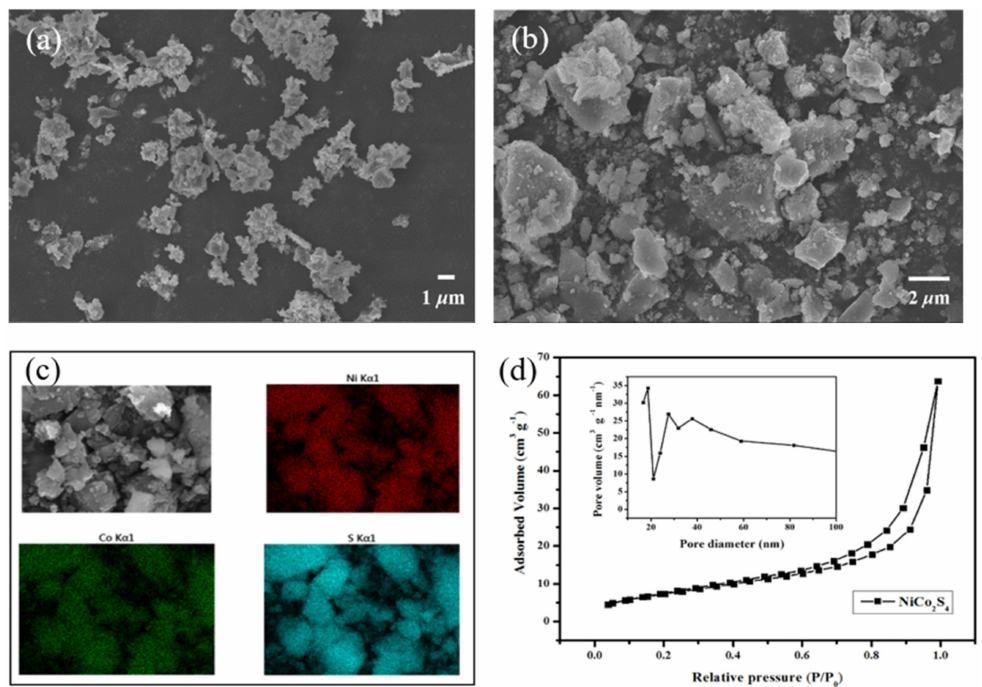
Figure 3. SEM images of ( a ) the MISR-prepared and ( b ) the STR-prepared NiCo 2 S 4 . ( c ) Element distribution (EDS) of the MISR-prepared NiCo 2 S 4 ; ( d ) N 2 adsorption/desorption isotherms and PSDs (the insertion) of the MISR-prepared NiCo 2 S 4